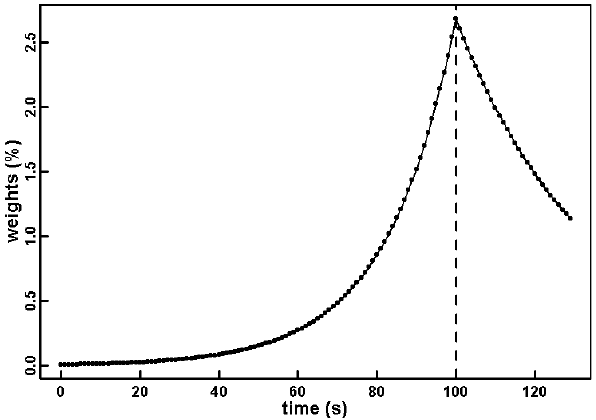
Fig. 5. he weighting function for integrating in situ measurements to compare them with the analysis result of one single flask, plotted as a function of time. The time scale is relative to a chosen time (100s for one single flask) prior to the start of pressurizing. The weights are given in percentages. The dashed line denotes the time when the pressurizing period starts. The weighting function is calculated based on the recorded and smoothed flask pressure during